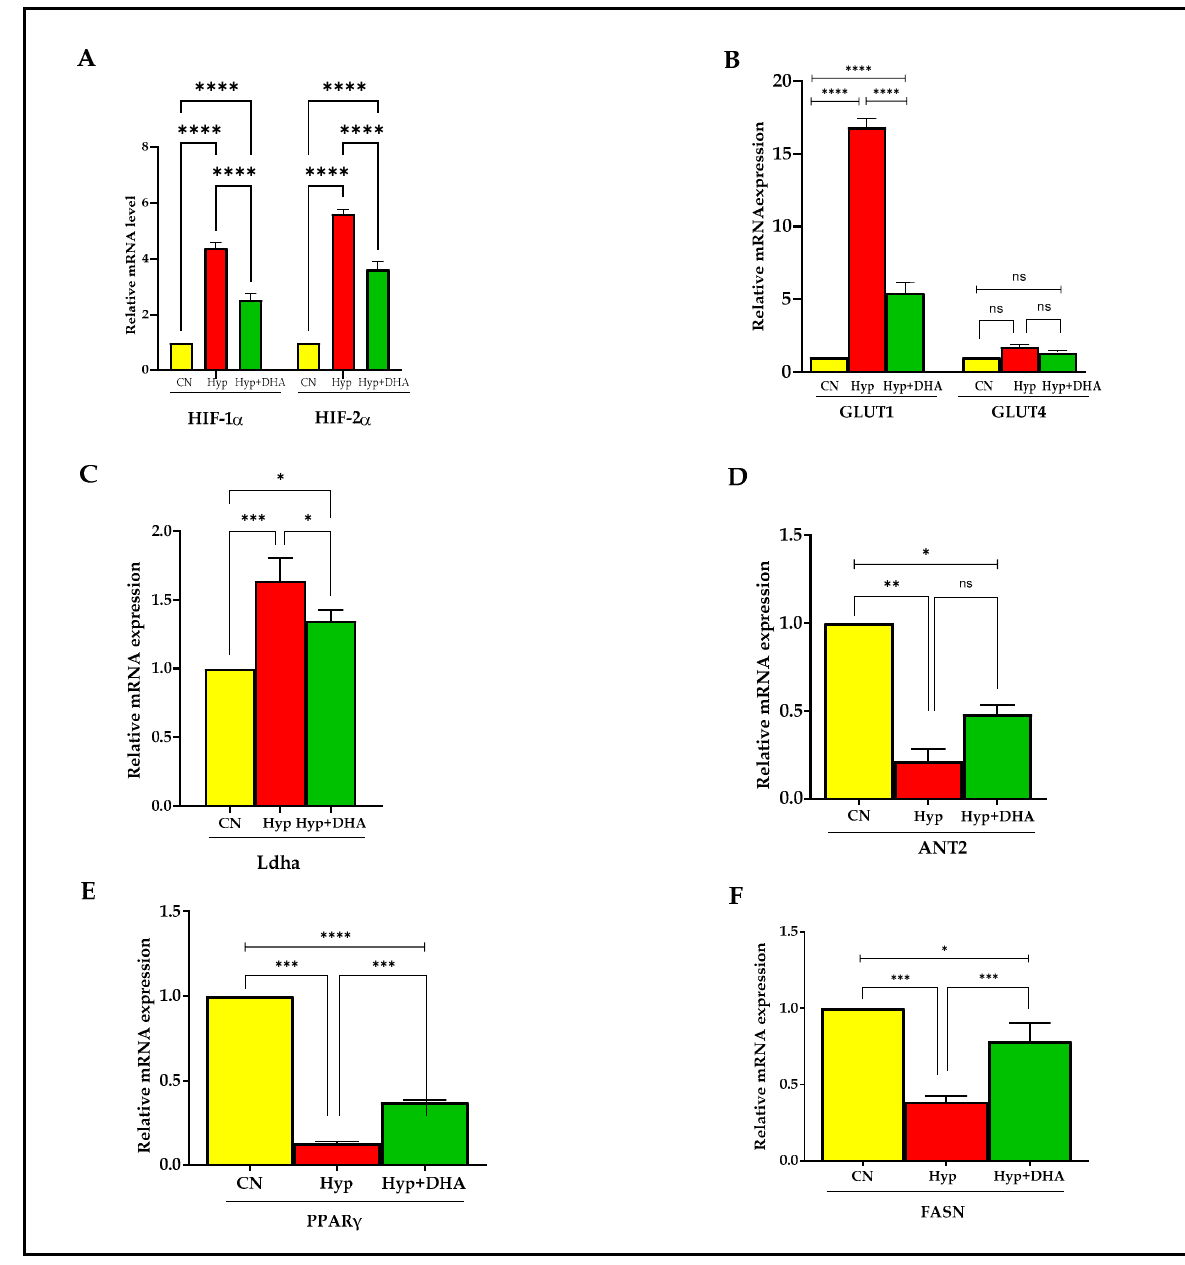
Figure 6. Quantification of mRNA level expression in 3T3L-1 adipocytes in response to hypoxic and DHA by RT-PCR. ( A – F ): Hypoxia-induced gene expression (mRNA) in normoxia, hypoxia, and hypoxia + DHA (50 uM) treatment in 3T3-L1 cells was determined against β -actin as a housekeeping gene by RT-PCR. Panel ( A ): HIF-1 α , HIF-2 α ; panel ( B ): GLUT1 and GLUT4; Panel ( C ): Ladh; Panel ( D ): ANT2; Panel ( E ): PPARy; Panel ( F ): FASN. Bars show the data (mRNA) presented as means ± SD of 3 independent experiments analyzed by one-way ANOVA and posthoc multiple comparison Tukey tests. Two-tailed p value is significant if p < 0.05. * p ≤ 0.05, ** p ≤ 0.005, *** p ≤ 0.0005, **** p < 0.0001; ns = not